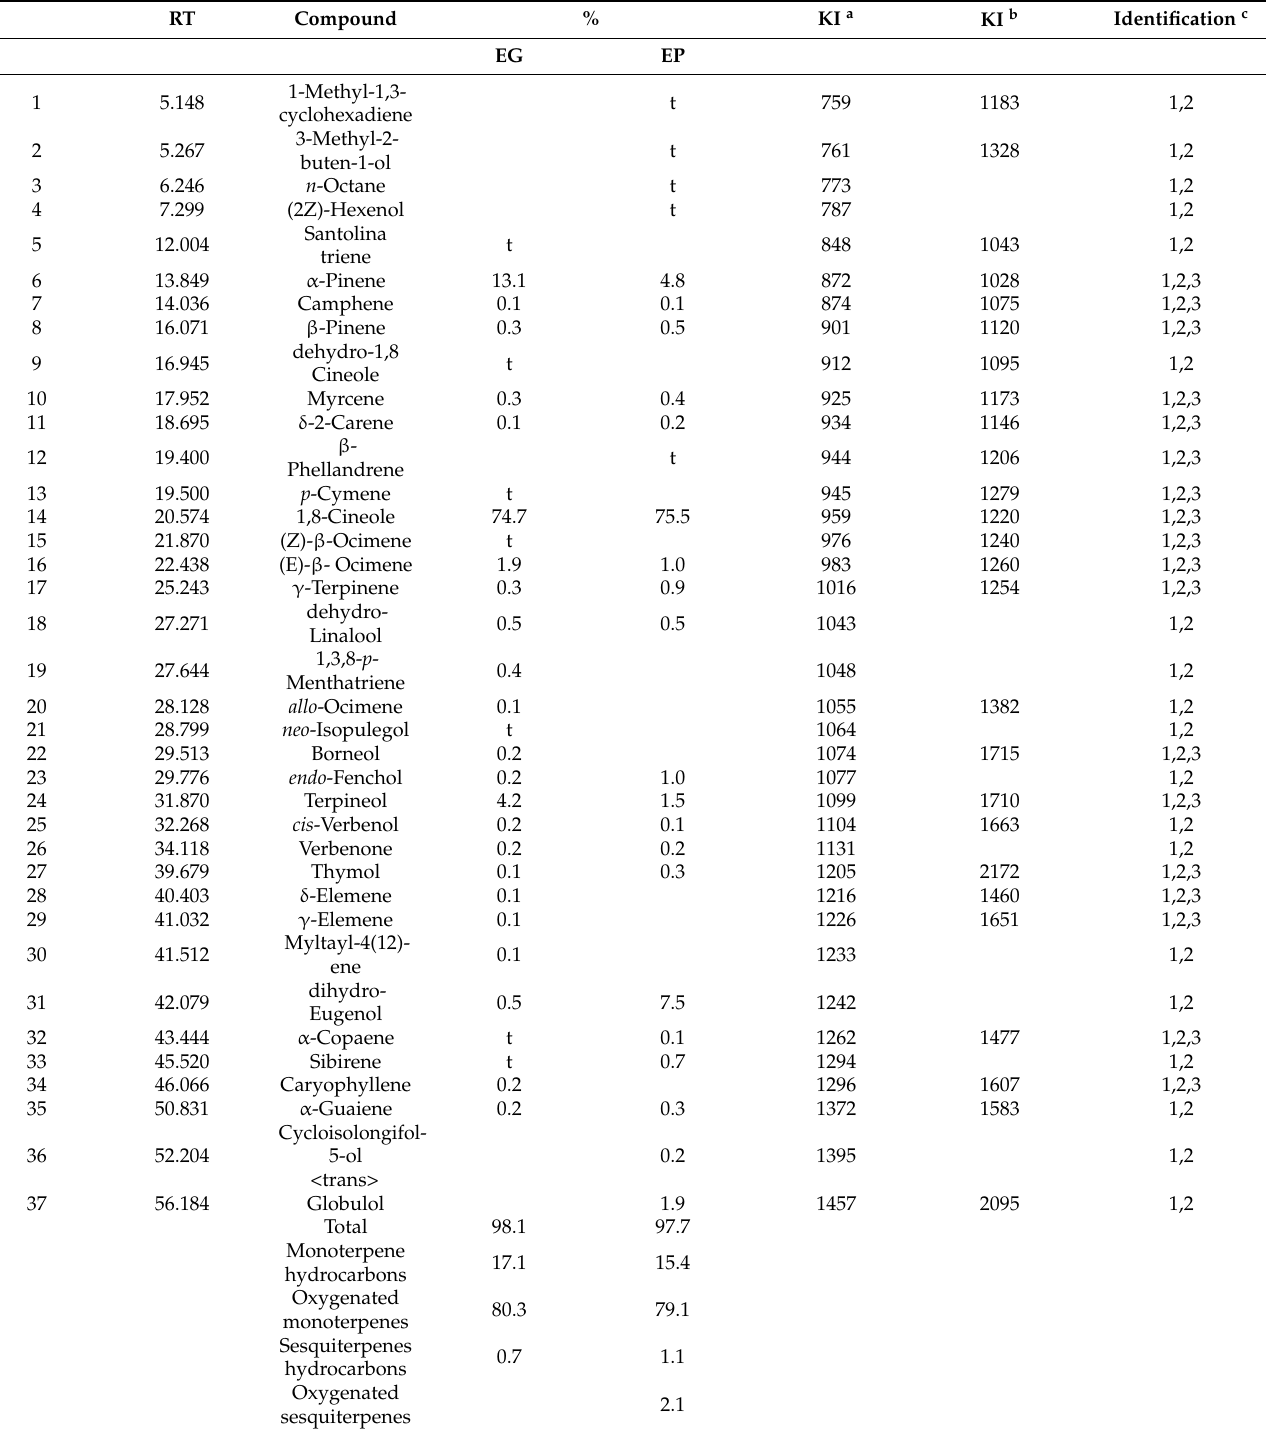
Table 2. Chemical composition of E. gunnii (EG) and E. pulverulenta ‘Baby blue’ (EP)